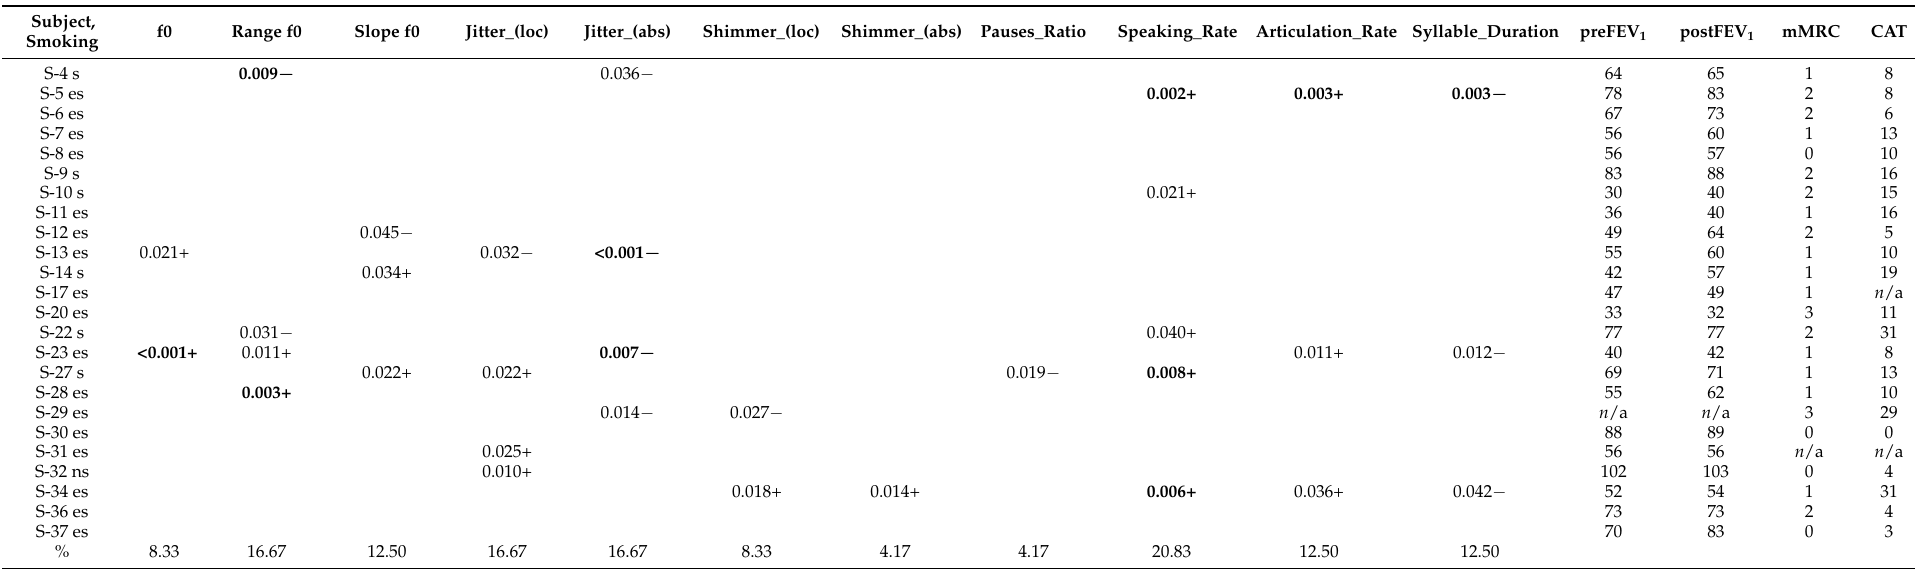
Table 4. Changes in speech features due to medication (study